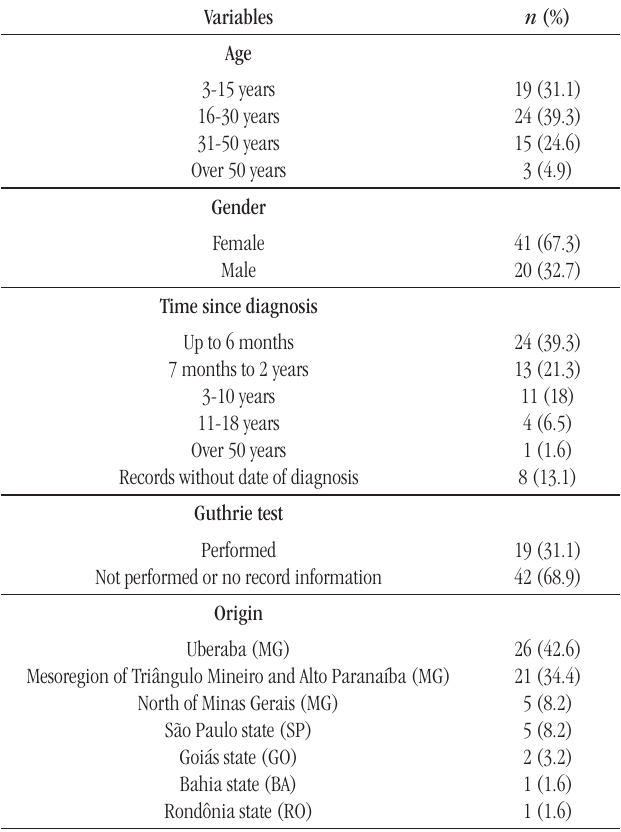
taBLE 1 − Patients’ characteristics in the study